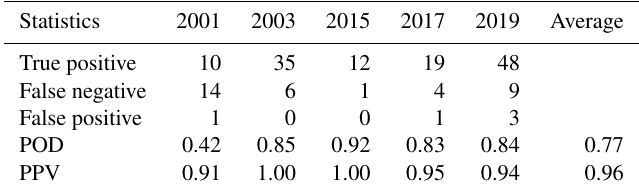
Table 2. Probability of detection and positive predictive values of SAFE.